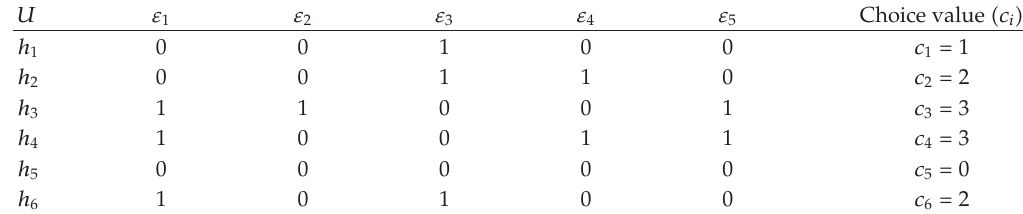
Table 7: Tabular representation of L (cid:5) S ; α,λ (cid:6) with choice values.